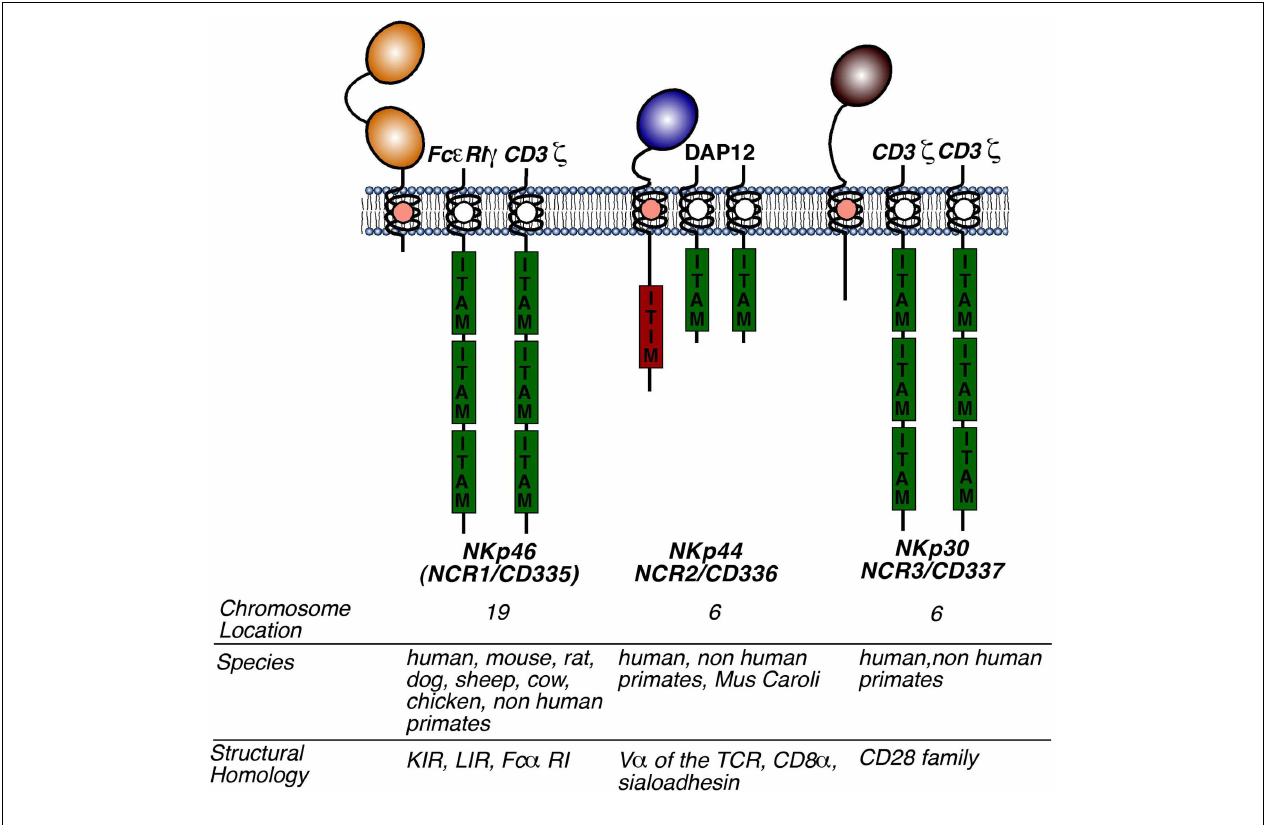
receptors homologous to the respective NCR. Abbreviations: KIR, killer immunoglobulin receptor; LIR, leukocyte immunoglobulin-like receptor; ITAM, immunoreceptor tyrosine-based activation motif; ITIM, immunoreceptor tyrosine-based inhibition